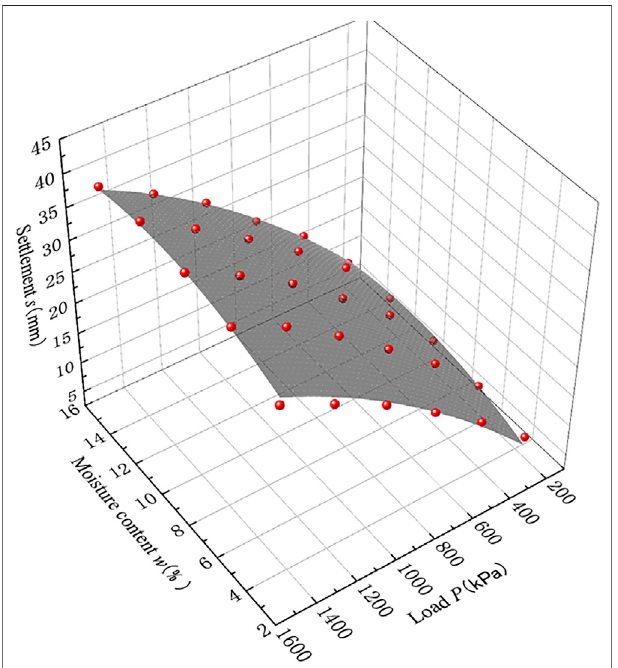
FIGURE 8 | Settlement vs moisture content and load.